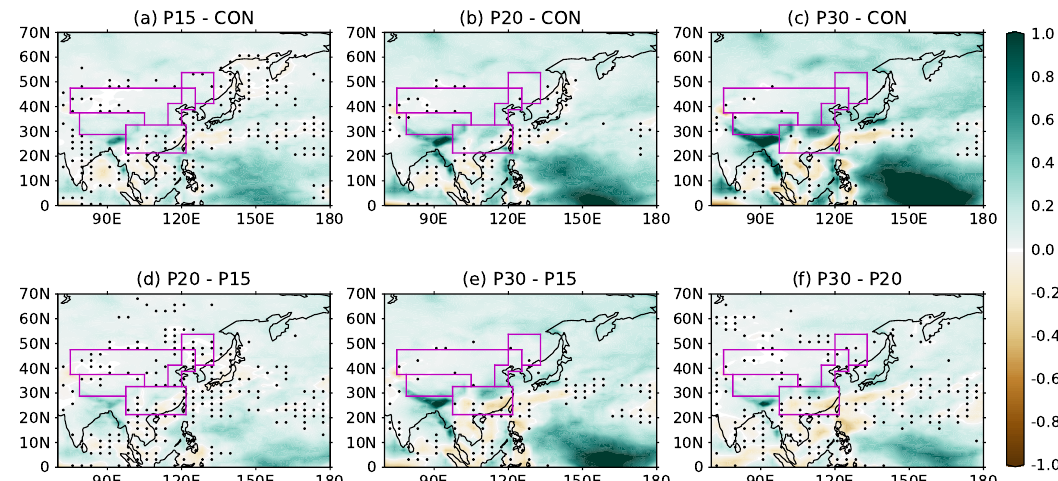
Figure 4. Annual-mean ensemble-mean precipitation differences (mm day − 1 ) between ( a ) P15 and CON, ( b ) P20 and CON, ( c ) P30 and CON, ( d ) P20 and P15, ( e ) P30 and P15 and ( f ) P30 and P20. The stippling (black dots) marks regions where less than 70% of the ensemble members agree with the sign of the change. The five regions are demarcated by the regional boundaries in magenta.